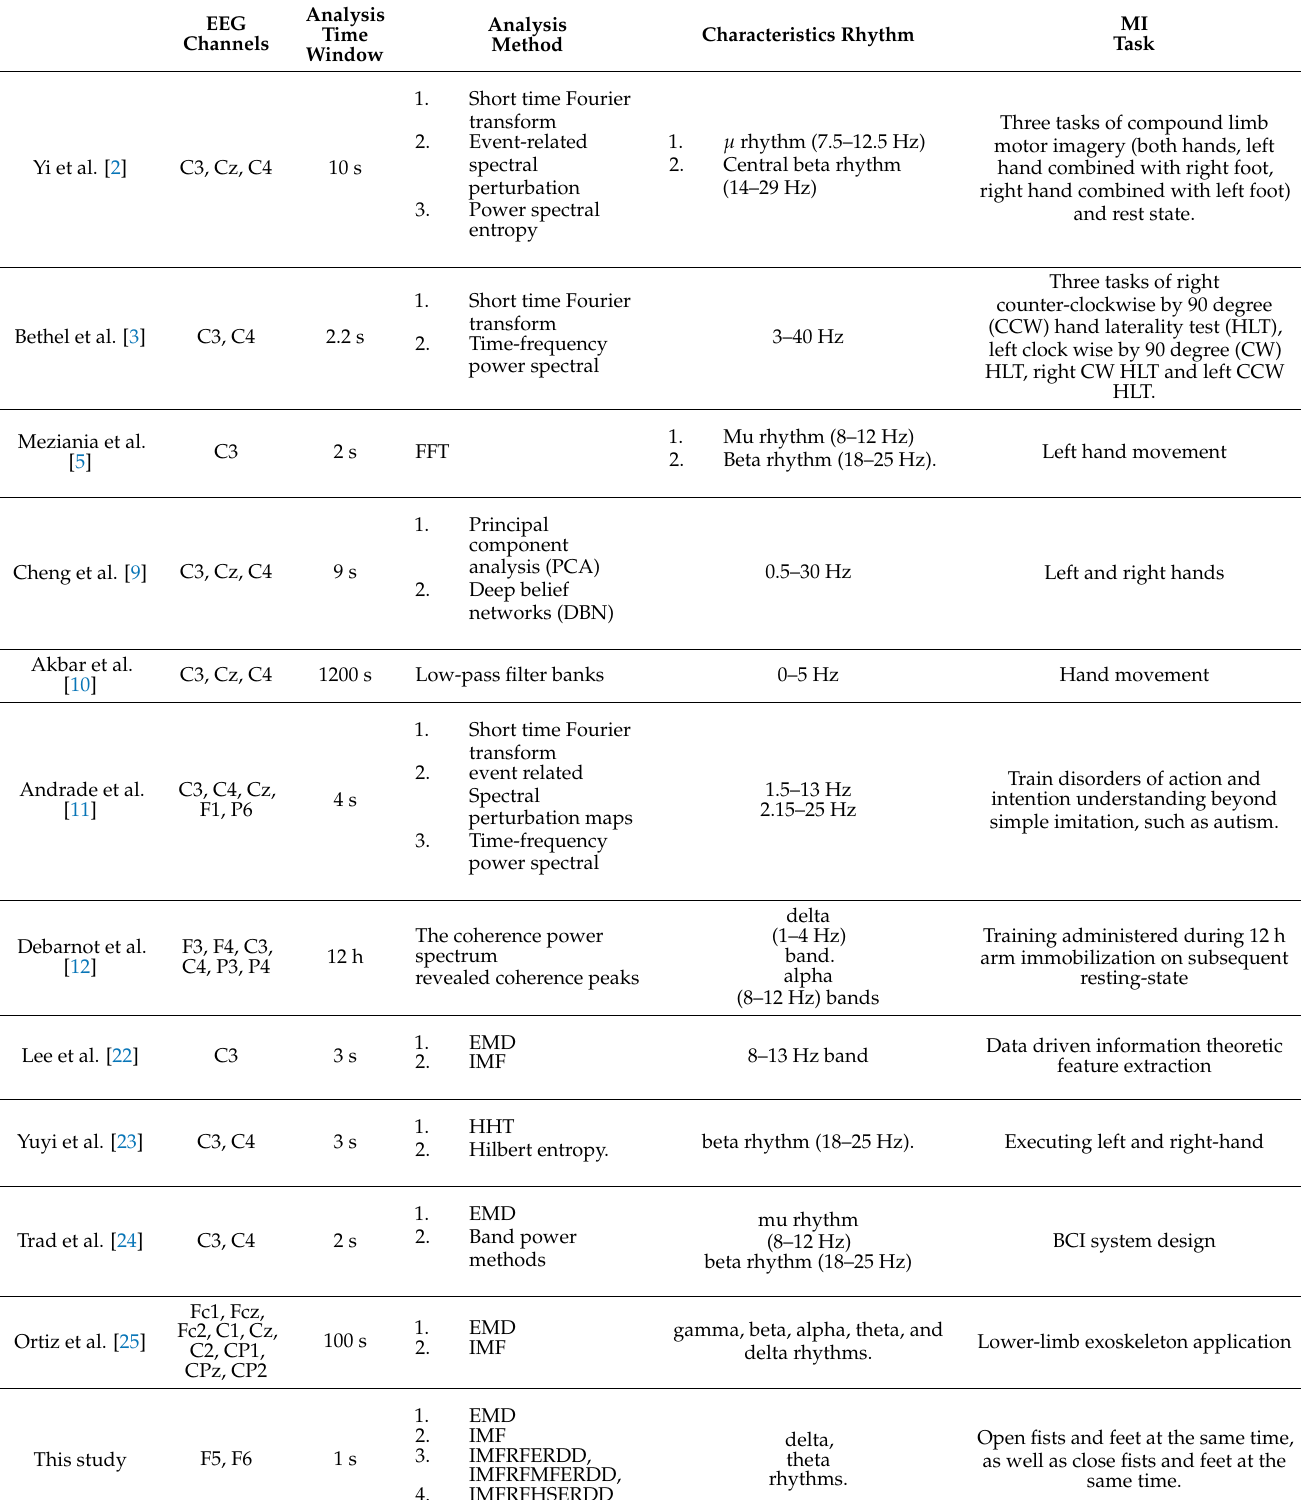
Table 1. Comparison of features extracted methods with application to MI-based EEG